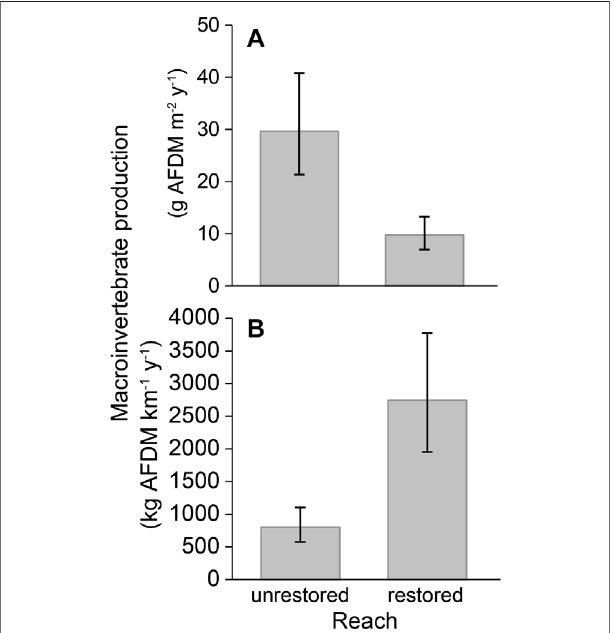
FIGURE 9 | Macroinvertebrate production on the South Fork McKenzie River, OR: (A) on a persquare-meter basis, and; (B) per kilometer of valley